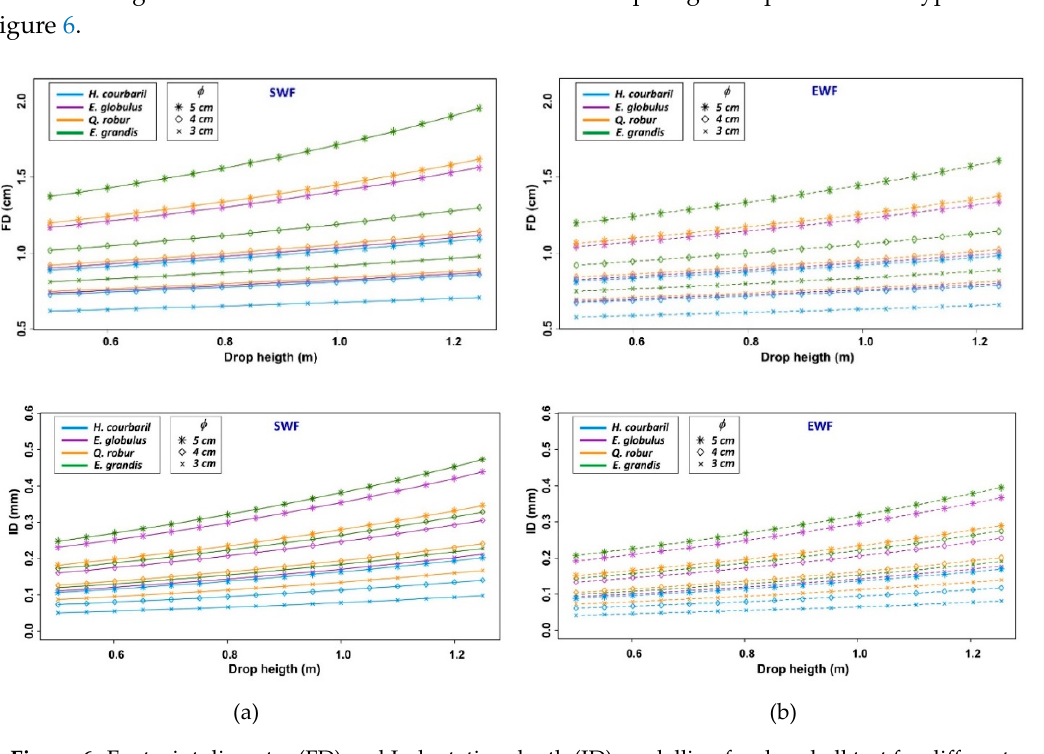
Figure 6. Footprint diameter (FD) and Indentation depth (ID) modelling for drop ball test for different values of the independent variables. ( a ) solid wood flooring (SWF); ( b ) engineered wood flooring (EWF). Model validation was carried out, checking the model with external bibliographic